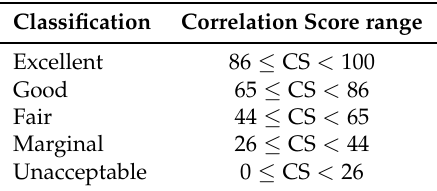
Table 5. Bio-fidelity classifications adapted from [102]. The classifications have an equivalent distribution but the range is increased by a factor of 10 (from a 0 to 10 range, to 0 to 100). CS is the Correlation Score. Classification Correlation Score range Excellent 86 ≤ CS < 100 Good 65 ≤ CS < 86 Fair 44 ≤ CS < 65 Marginal 26 ≤ CS < 44 Unacceptable 0 ≤ CS <